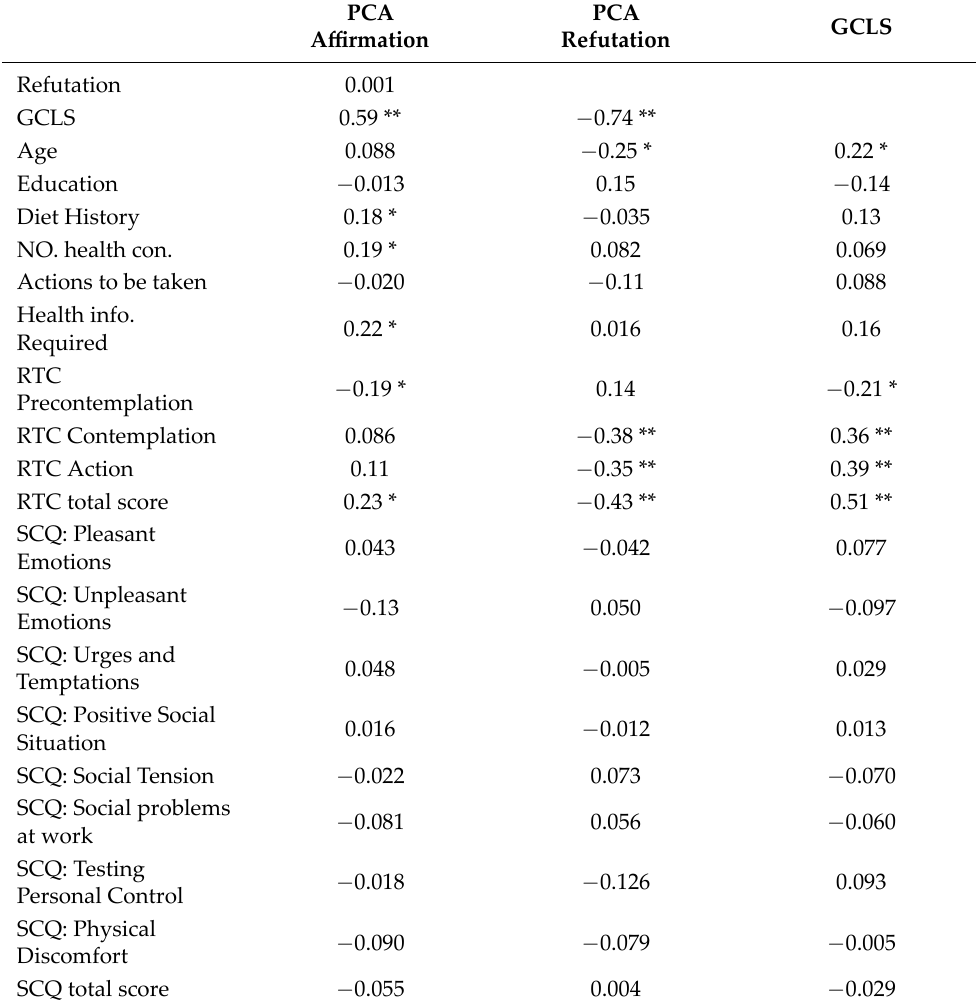
Table 3. Correlation matrix of GAS scale PCA Component 1 (Affirmation) and Component 2 (Refu‑ tation), Goal Commitment Likelihood Score (GCLS) with the study outcome measures for the exper‑ imental